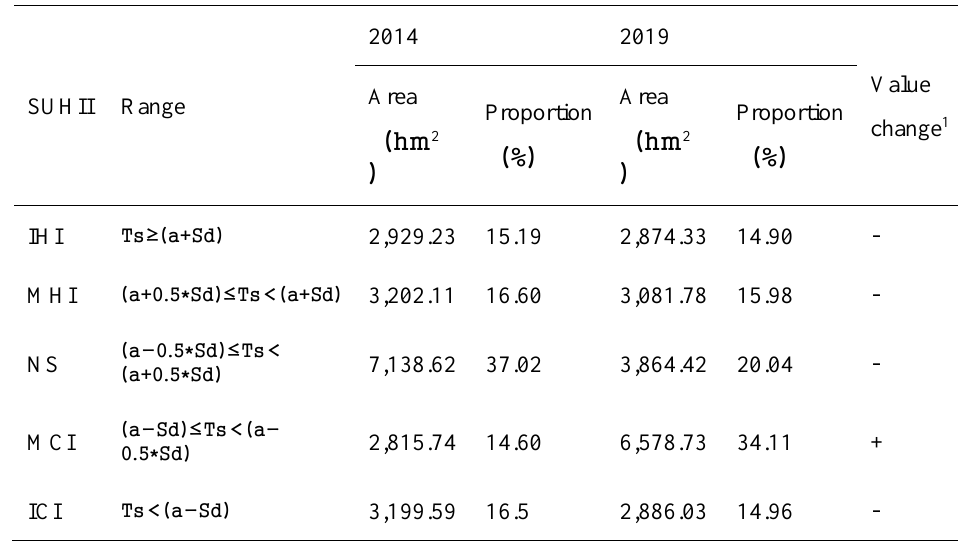
Figure 2. Classification of UHII within the Third Ring Road of Chengdu in 2014 and 2019 Table 2. Classification of